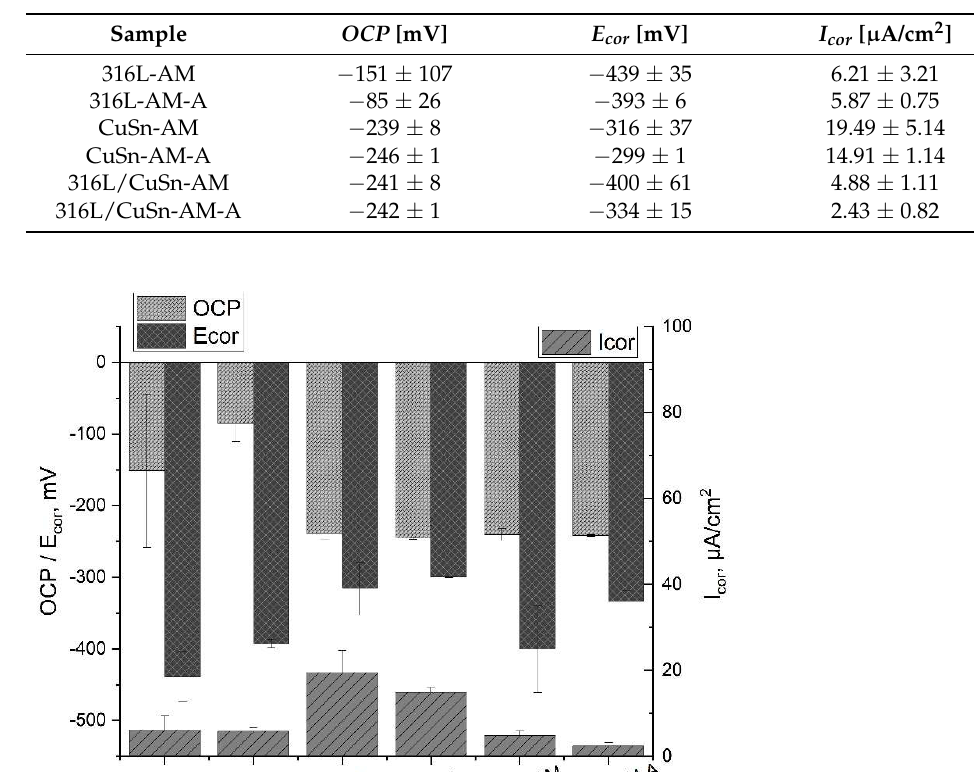
Table 6. LSV measured values of the additive samples before and after heat treatment.